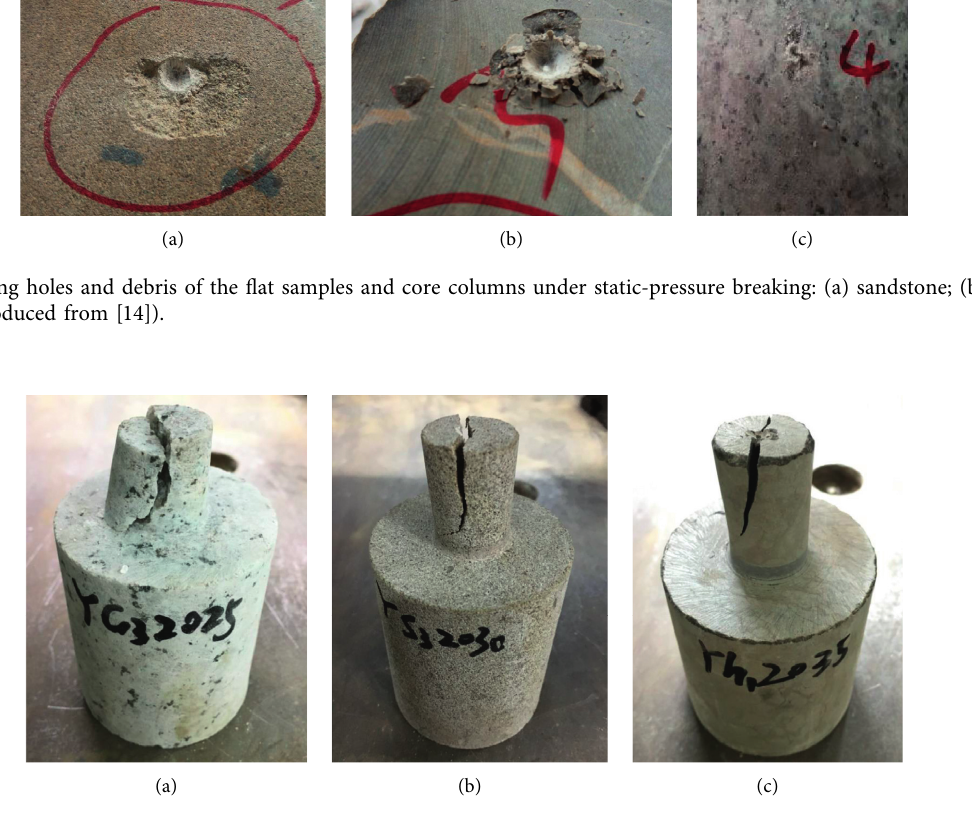
Figure 7: Broken core columns under static-pressure breaking: (a) sandstone; (b) limestone; (c)